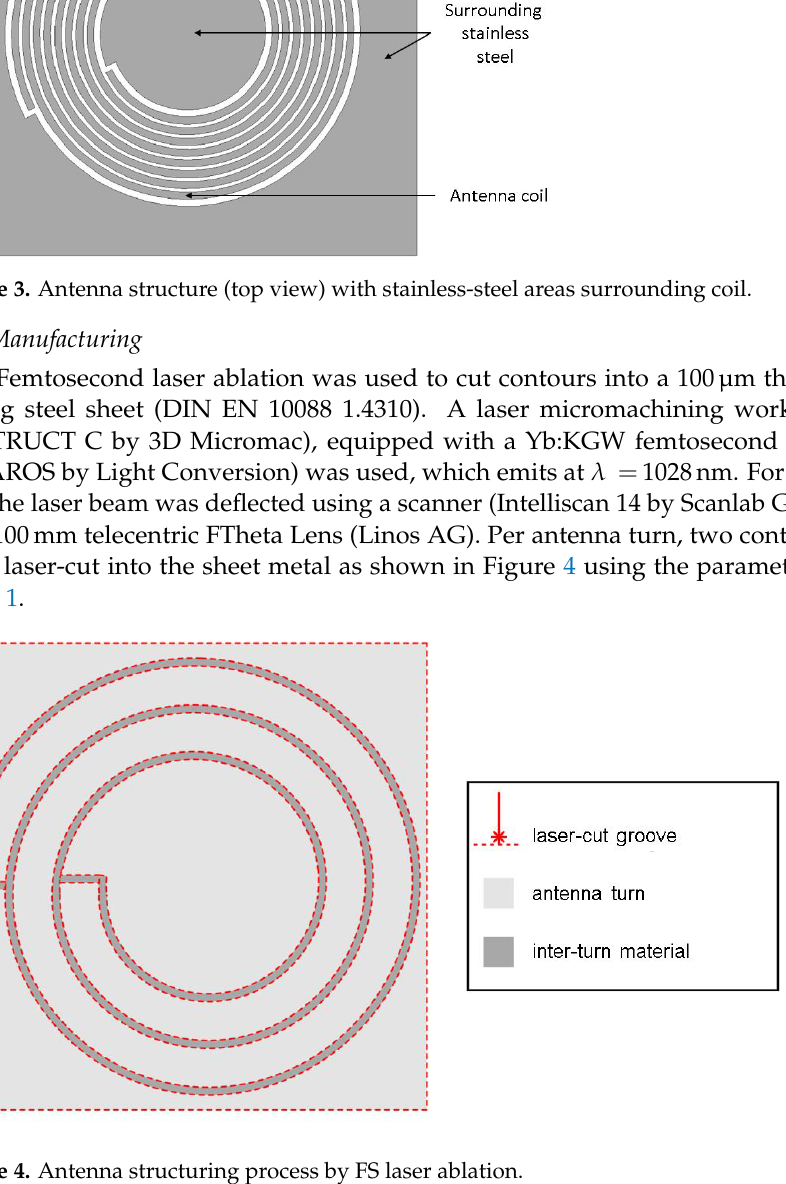
Figure 4. Antenna structuring process by FS laser